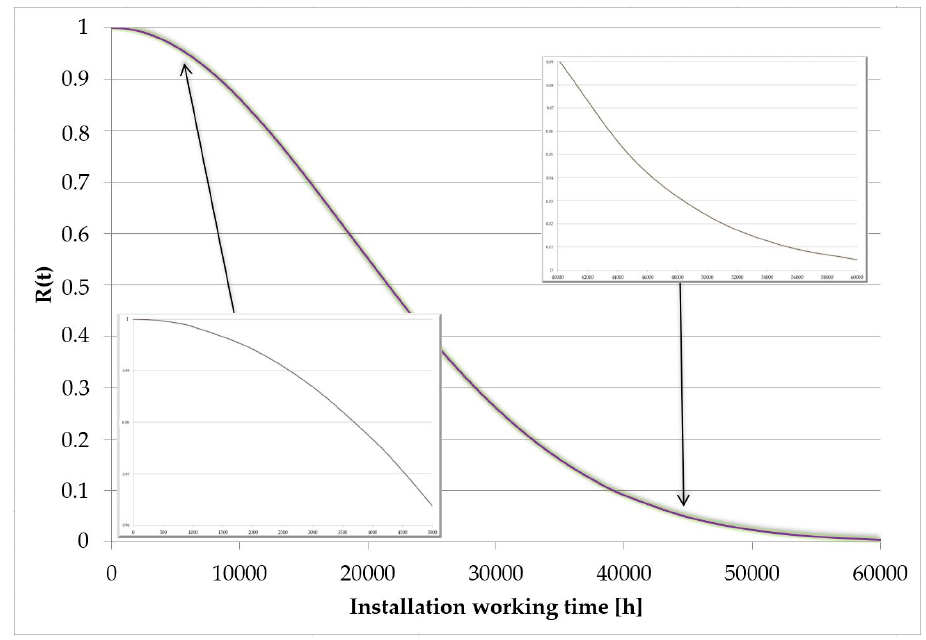
Figure 6. The distribution of the reliability function R(t) of the CHP plant in time.